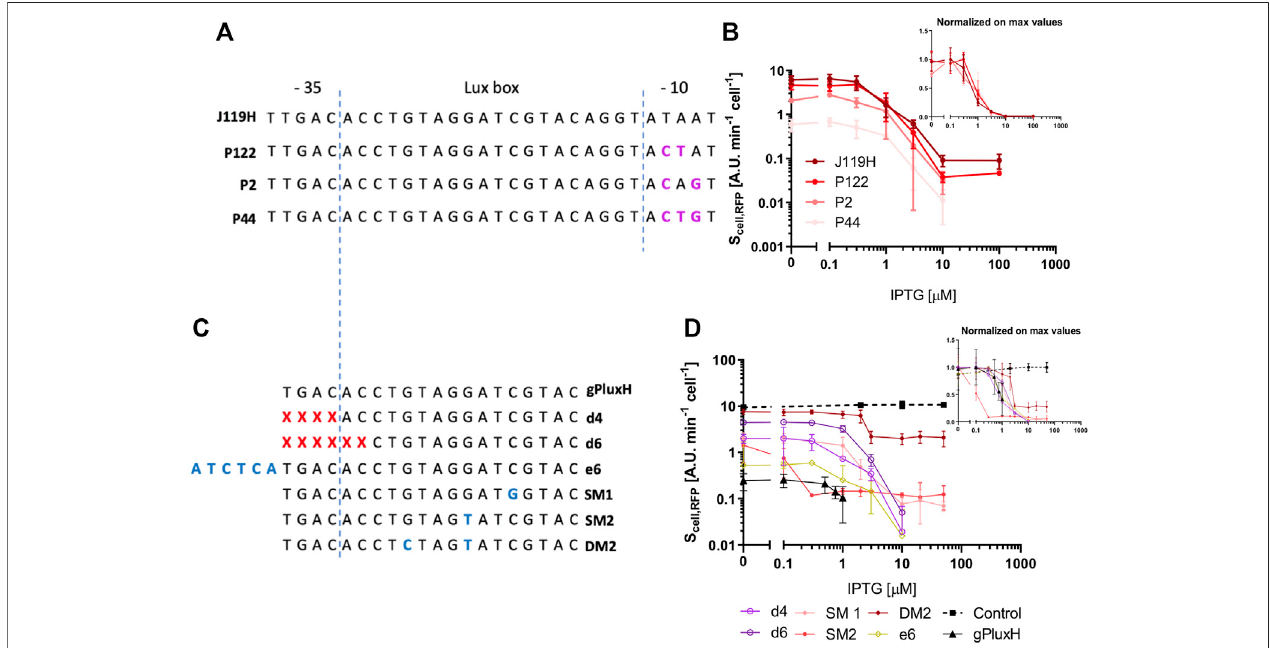
FIGURE 6 | Tunability of CRISPRi modules. (A) Architecture of four members of a LuxR-repressible promoter library used in this work. They share the − 35 sequenceandtheluxboxinthecoreregion,whilethemutationsinthe − 10sequenceaffecttheirtranscriptionalstrengths.ThegPluxHguidetargetsthesameregioninall the four promoters, from nucleotide 2 to 21. (B) Transfer functions, with RFP as output, are reported as a function of IPTG concentration, driving gPluxH expression in four circuits with constitutive dCas9, IPTG-inducible sgRNA, and P luxRep , P 122 , P 2 or P 44 as target promoter. The inset shows the same graph with values normalized by the maximum data point of each transfer curve. (C) Description of the gPluxH variants. Blue nucleotides represent mismatches compared with the target sequence. (D) Transfer functions, with RFP as output, are reported as a function of IPTG concentration, driving the gPluxH variants expression in different circuits with constitutivedCas9,IPTG-induciblesgRNA,andP luxRep astargetpromoterdrivingRFPinamediumcopyplasmid.Thecontrolrepresentsanidenticalcircuitbutincluding the gPtet guide, which is not able to target P luxRep . In panels (B,D) , data are shown as the average RFP synthesis rate per cell and data points represent the average value, with error bars representing the standard errors of the mean of at least three independent